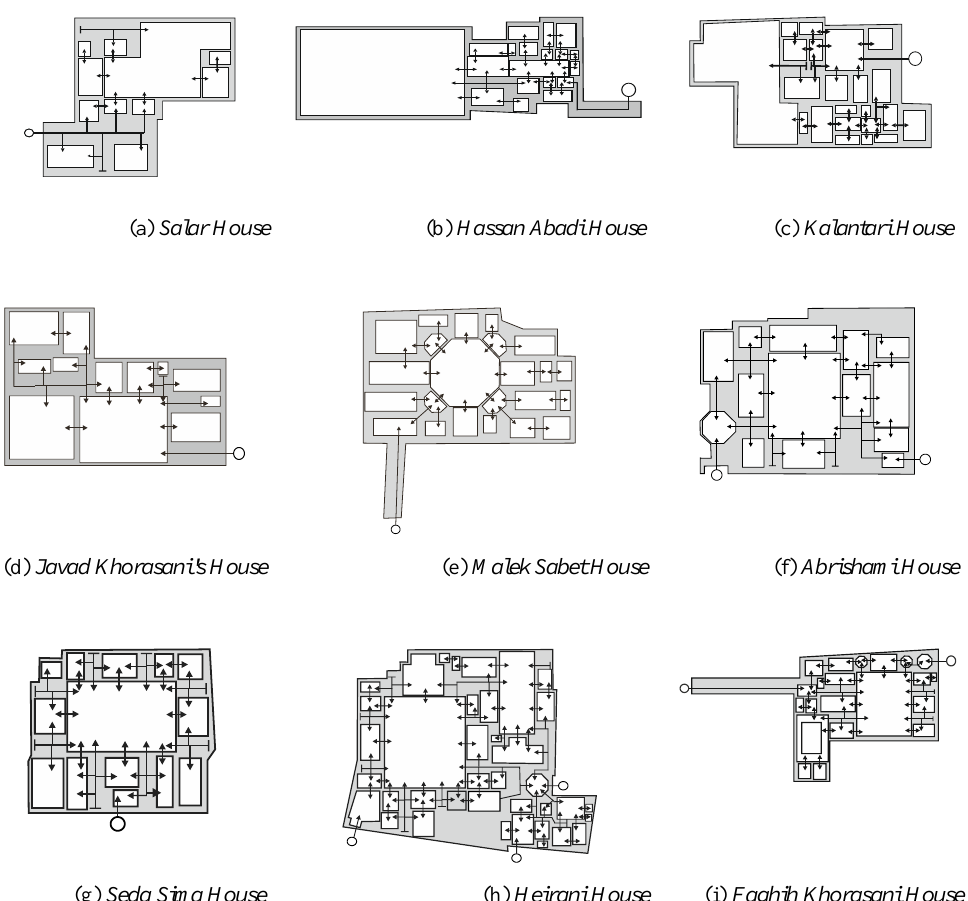
Figure 1. Nine example plans of Yazd courtyard houses depicting habitable spaces (white), both enclosed and open to the sky, and trafficable connections between spaces (arrows).